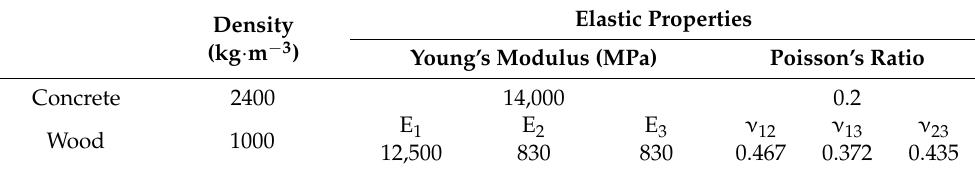
Table 2. Properties of the impact surface used.